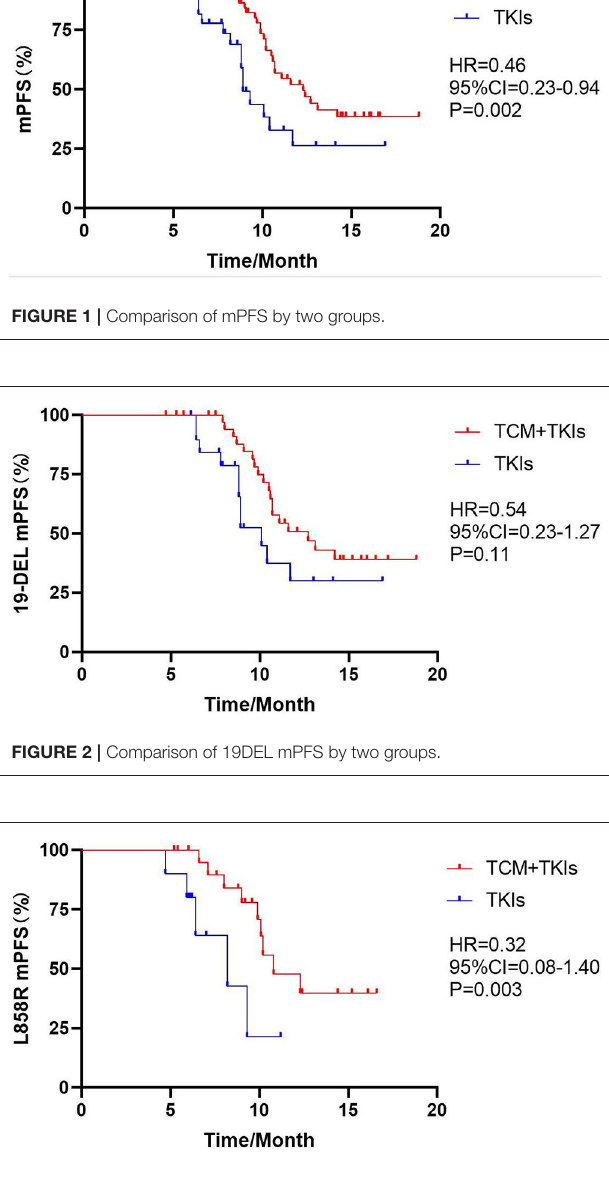
FIGURE 3 | Comparison of L858R mPFS by two groups.